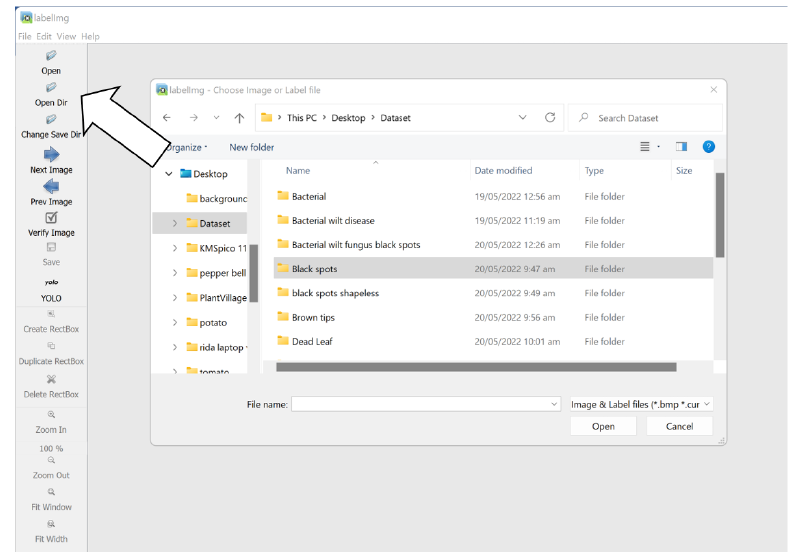
Figure 4. Image selection for labeling.